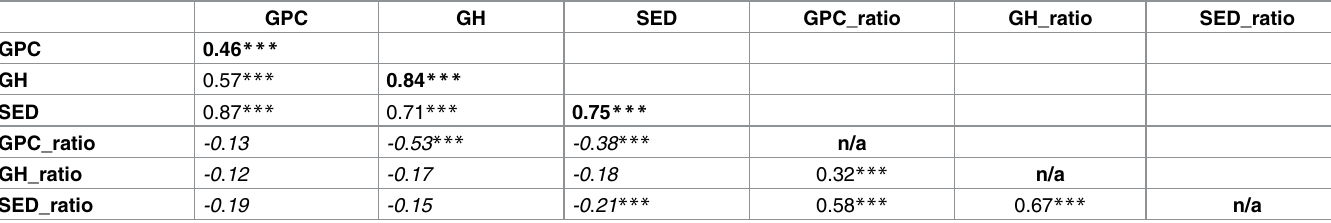
Table 3. Genetic correlation (pearson’s correlation coefficient r) calculated across N levels between six traits studied. GPC